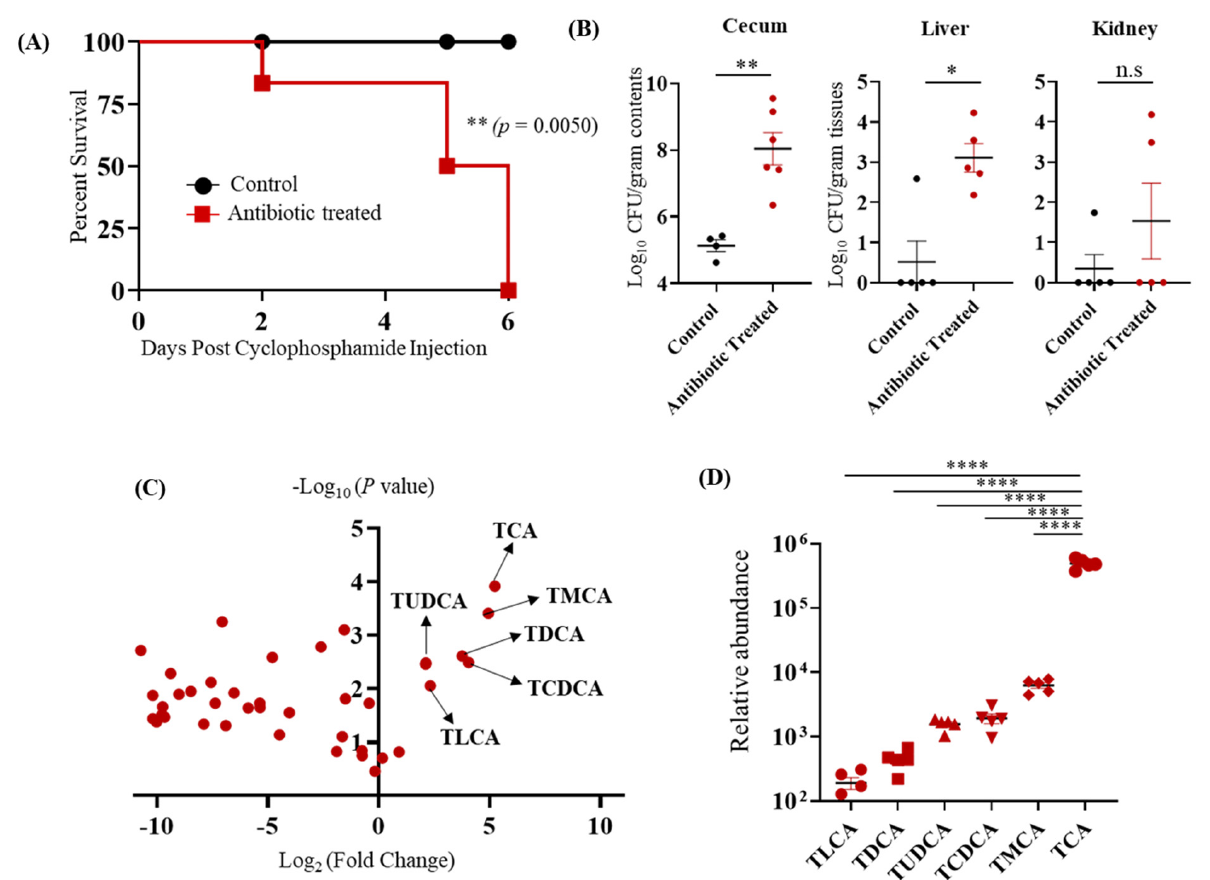
Figure 1. Taurocholic acid (TCA) is the major bile acid metabolite up-regulated in the cefoperazone-treated mice susceptible to CA infection. ( A ) BALB/c mice were fed sterile water in the presence or absence of cefoperazone (0.5 mg/mL) for 7 days and then infected with ~2 × 10 8 CFU CA SC5314 via oral gavage. Antibiotic treatment was continued until the end of the experiment. Three days post-infection, all mice were injected with three doses of cyclophosphamide intraperitoneally (150 mg/kg body weight) and monitored for survival. A log-rank test was performed using 95% confidence intervals; statistical significance was calculated to compare the antibiotic-treated and untreated control groups. ( B ) Fungal load from cecum, liver, and kidney were collected immediately after death in the antibiotic-treated groups and mice euthanized after 6 days post-cyclophosphamide treatment from control groups. Statistical significance was evaluated using the Mann–Whitney U test. ( C ) Relative Log 2 fold-change of bile acid metabolites in antibiotic-treated C57BL/6 mice relative to control groups. ( D ) Relative abundance of bile acid metabolites that were highly up-regulated and significant in the antibiotic-treated group relative to control groups. At least five mice per group were used, and the data represents mean ± SEM. one way-ANOVA followed by a multiple comparison using Bonferroni correction. p values of (* p ≤ 0.05), (** p ≤ 0.01), and (**** p ≤ 0.0001) were considered as significant.